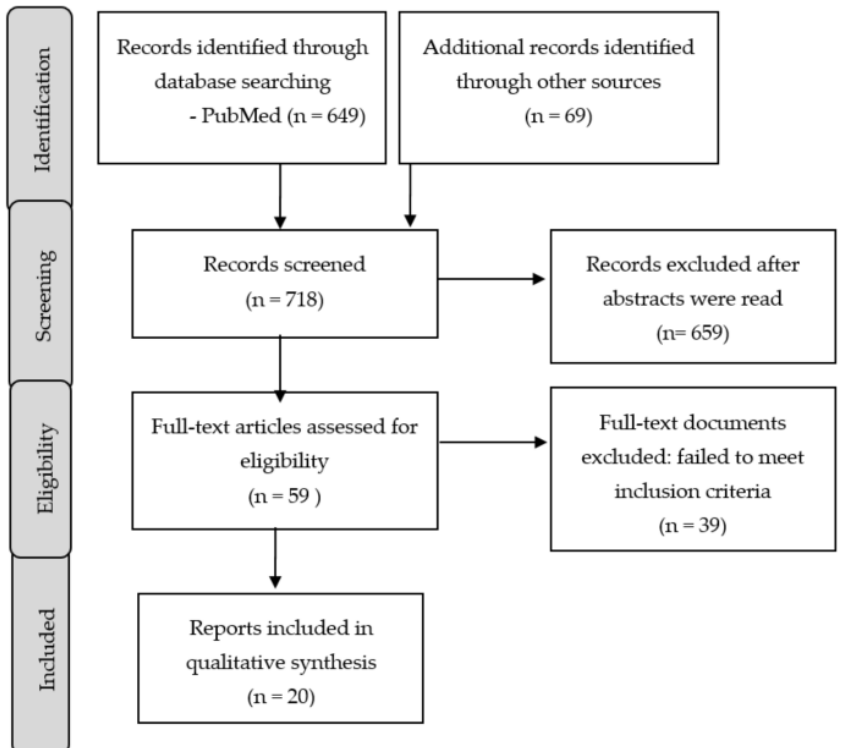
Figure 1. Flowchart for search leading to study inclusion.